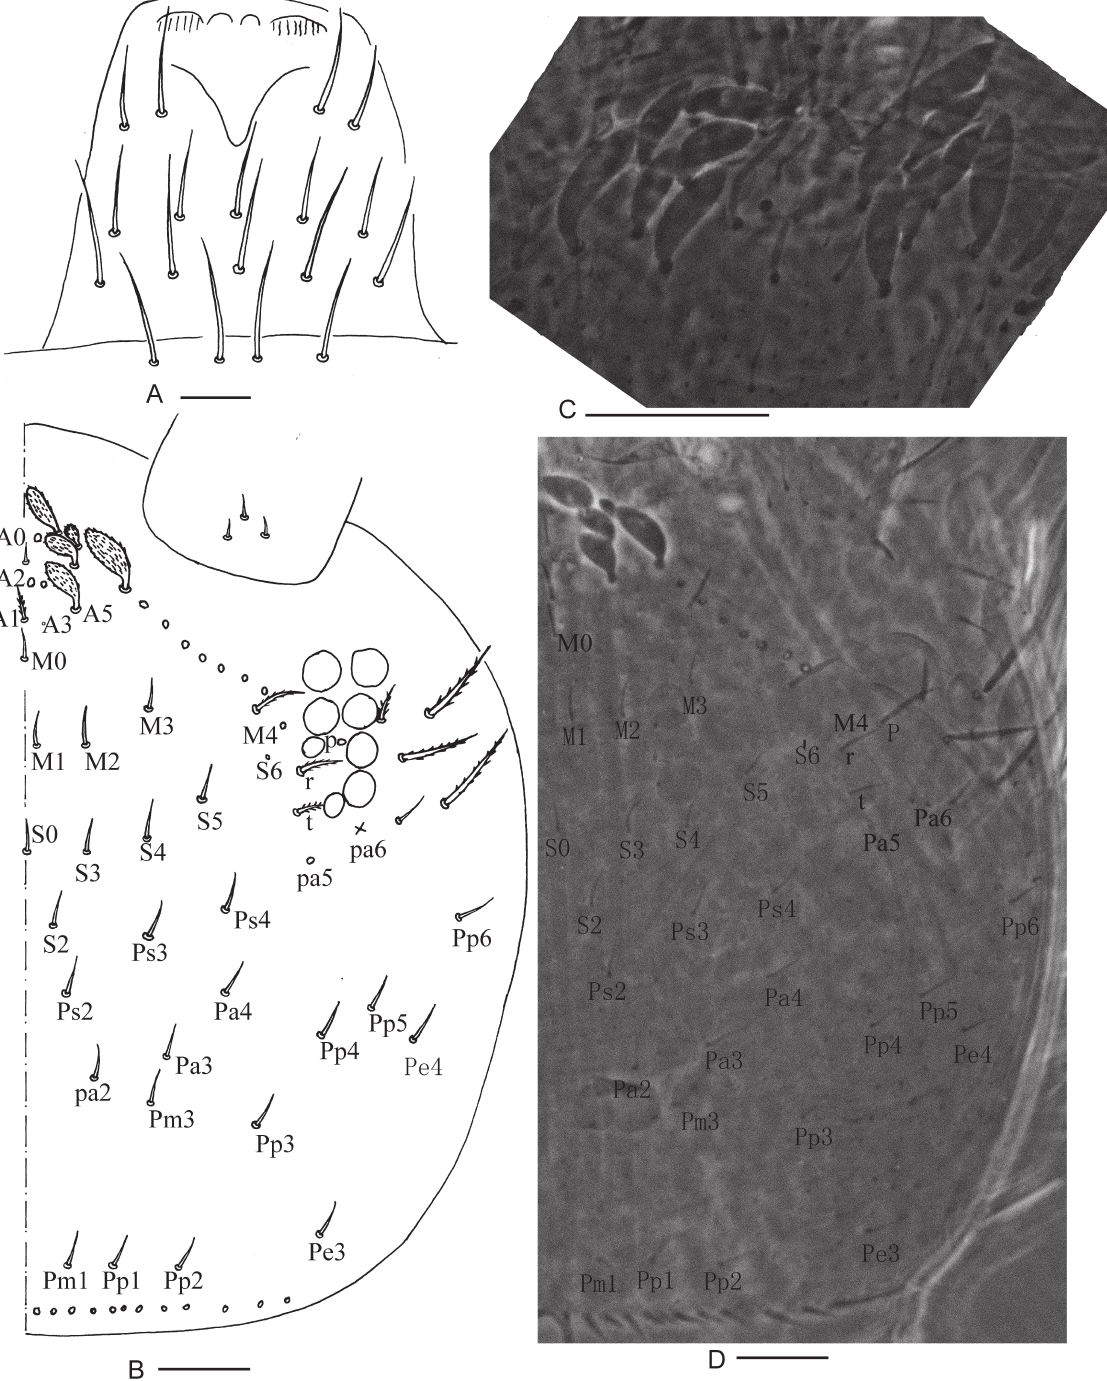
Fig. 3. Lepidocyrtus ( A. ) huizhouensis sp. nov. A . Labrum. B . Dorsal chaetotaxy of head (right side). C . Anterior part of dorsal head. D . Dorsal chaetotaxy of head (right side). Scale bars: 20